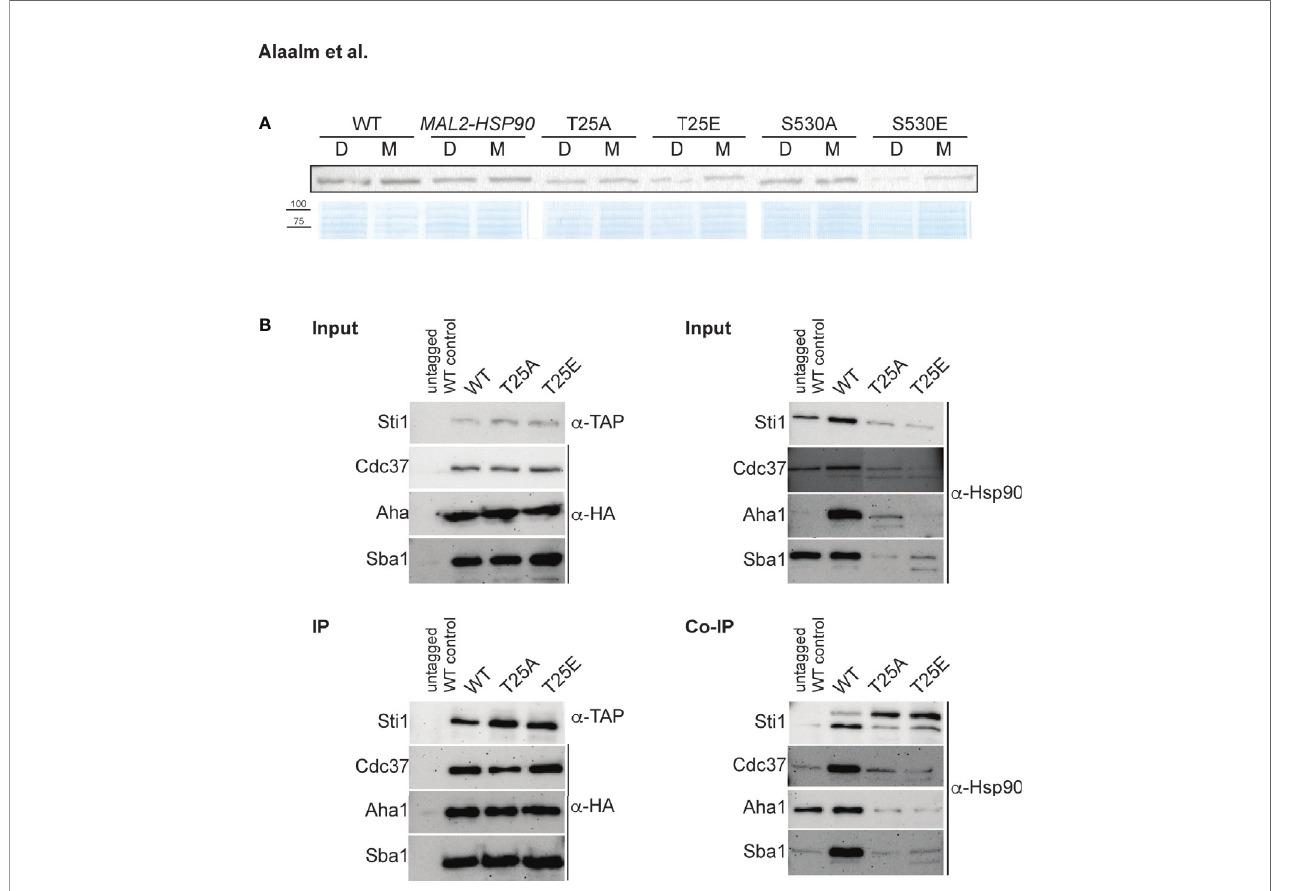
FIGURE 2 | The C. albicans Hsp90 co-chaperone machinery is regulated by phosphorylation. (A) One of two Western blots probed for presence of Hsp90 in C. albicans wild-type (WT), promoter control ( MAL2-HSP90 ) and T25 and S530 mutant strains (top). Strains were grown in media containing either maltose (M) or dextrose (D) to regulate expression of mutant hsp90 via the maltose-inducible promoter. A Coomassie-stained SDS gel validates equal loading of protein samples (bottom). (B) TAP-tagged Sti1 and HA-tagged co-chaperones Cdc37, Aha1, and Sba1 were co-immunoprecipitated with Hsp90 in the wild type (WT) and the T25 mutants. The input was fi rst probed for presence of co-chaperones and Hsp90 prior to immunoprecipitation with IgG or a -HA agarose targeting the co-chaperones. Levels of co-chaperones were then assessed in the immunoprecipitate (IP) using a -TAP and a -HA antibodies. To screen for co-immunoprecipitated Hsp90 (Co-IP), the membrane was probed with an Hsp90-speci fi c